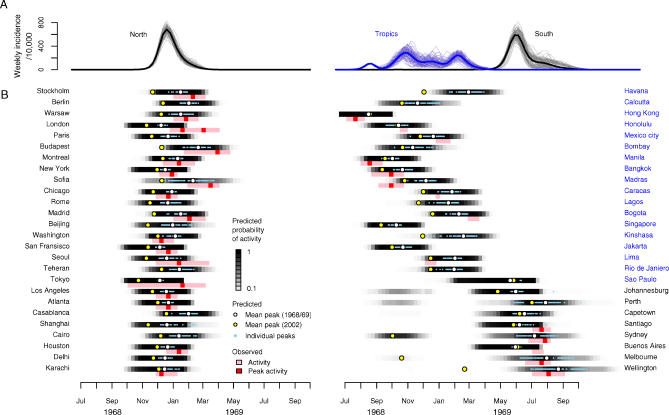
Predicted and Observed Times of Influenza Activity and Epidemic Peaks in 1968/9(A) Predicted combined incidence using baseline model assumptions (bold lines show mean incidence).(B) Observed and predicted times in individual cities. Peak times from individual simulation runs and mean peak times with 1968/9 data are shown as blue and white dots, respectively. Mean peak times that would have occurred with 2002 travel patterns are shown as yellow dots. Predictions are based on 100 simulation runs. Influenza activity was defined as at least one new symptomatic case per 100,000 people in a given week.